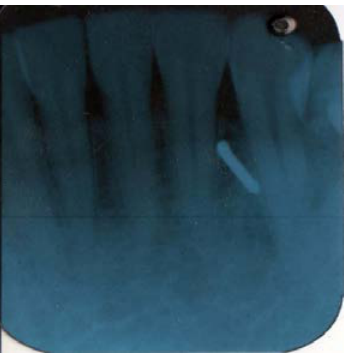
Figure 4. Pri-apical X-ray.